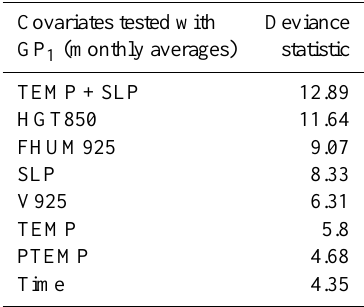
Table 2. Deviance statistic for the covariates tested with the GP